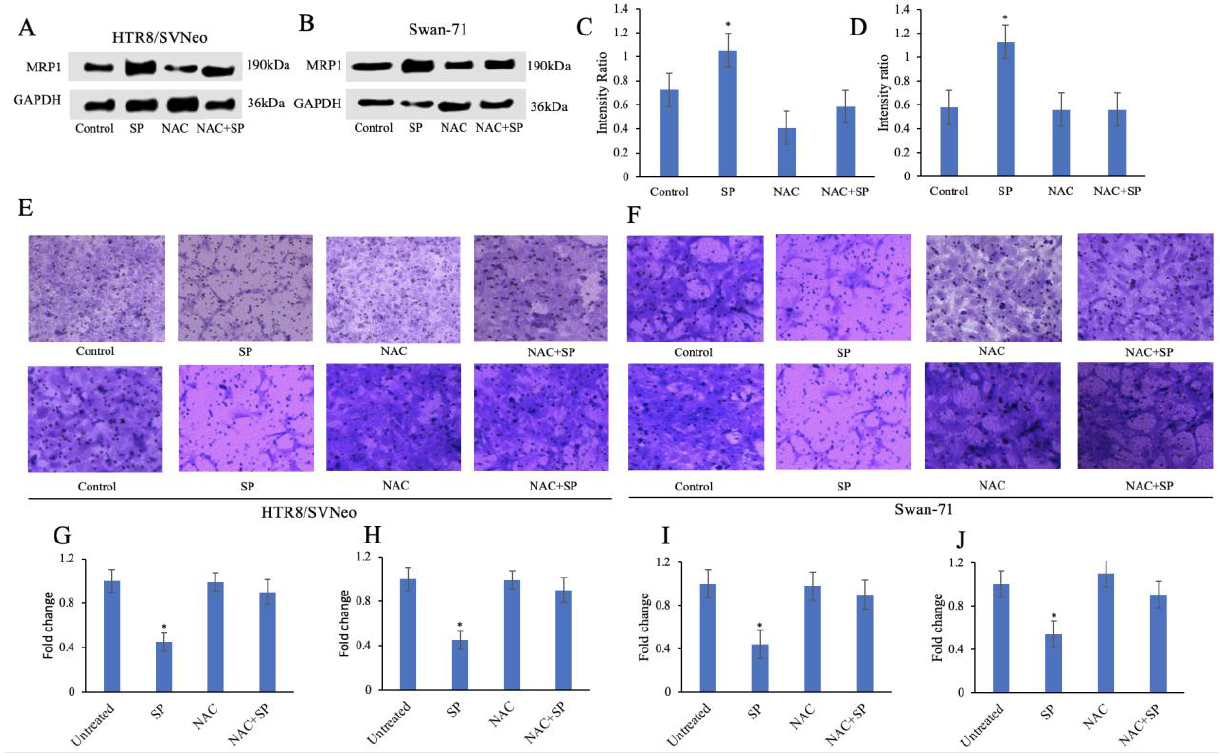
Figure 4. Effect of NAC on MRP1 expression and migration and invasion in palmitic acid-treated HTR-8/SVneo and Swan-71 cells . MRP1 expression in palmitic acid-treated HTR8/SVneo ( A ) and Swan-71cells ( B ) with or without NAC pretreatment determined by Western blotting. Grayscale ratios were calculated with the help of ImageJ ( C , D ). Migration (top row) and invasion (bottom row) of palmitic acid-treated HTR8/SVneo cells ( E ) and Swan-71 cells ( F ) with or without NAC pretreatment. Images were captured from the underside of the transwell inserts. Quantification ( G , H , I , J ) was carried out by counting the migrated or invaded cells using a hemocytometer. Mean values were obtained from three independent experiments and error bars represent SD. * p < 0.05 compared to controls.